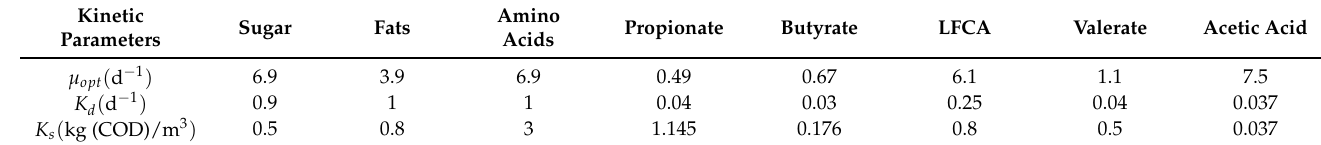
Table 3. Kinetic parameters [6].